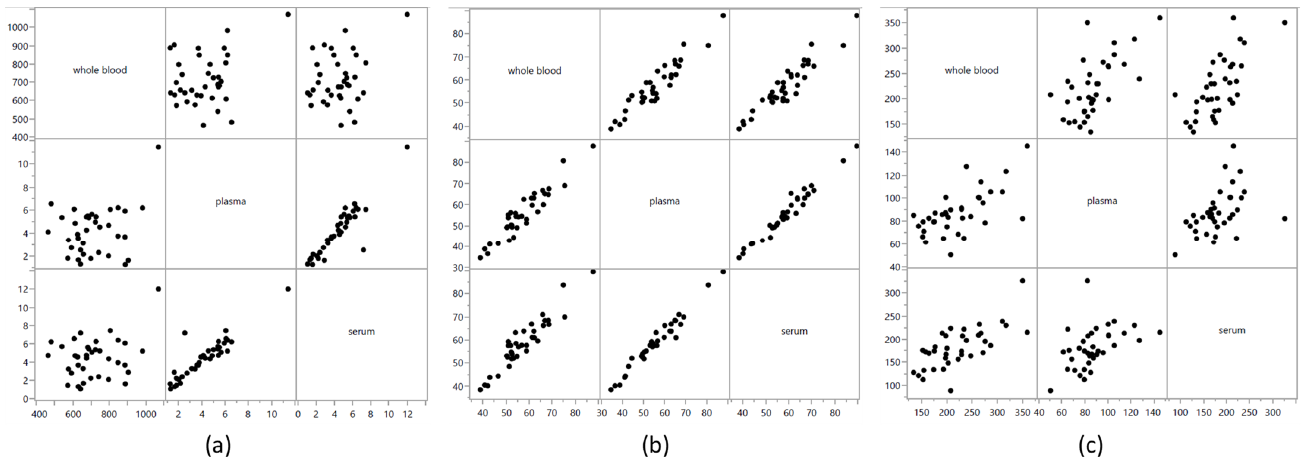
Figure 5. Spearman’s correlation of amino acid concentrations in whole blood, plasma, and serum from 36 healthy dogs. ( a ) α-aminoadipic acid, ( b ) isoleucine, ( c ) taurine. Axis values are in µM concentrations.